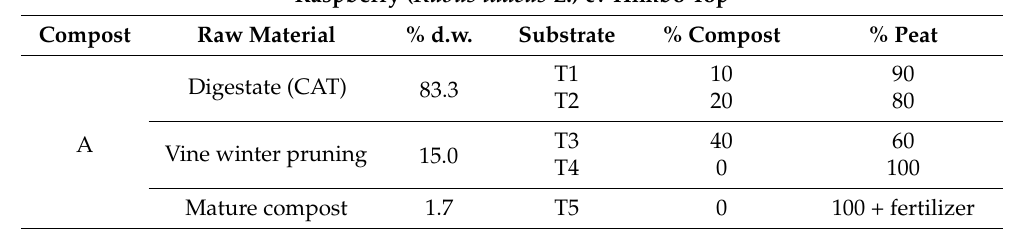
Compost Raw Material %